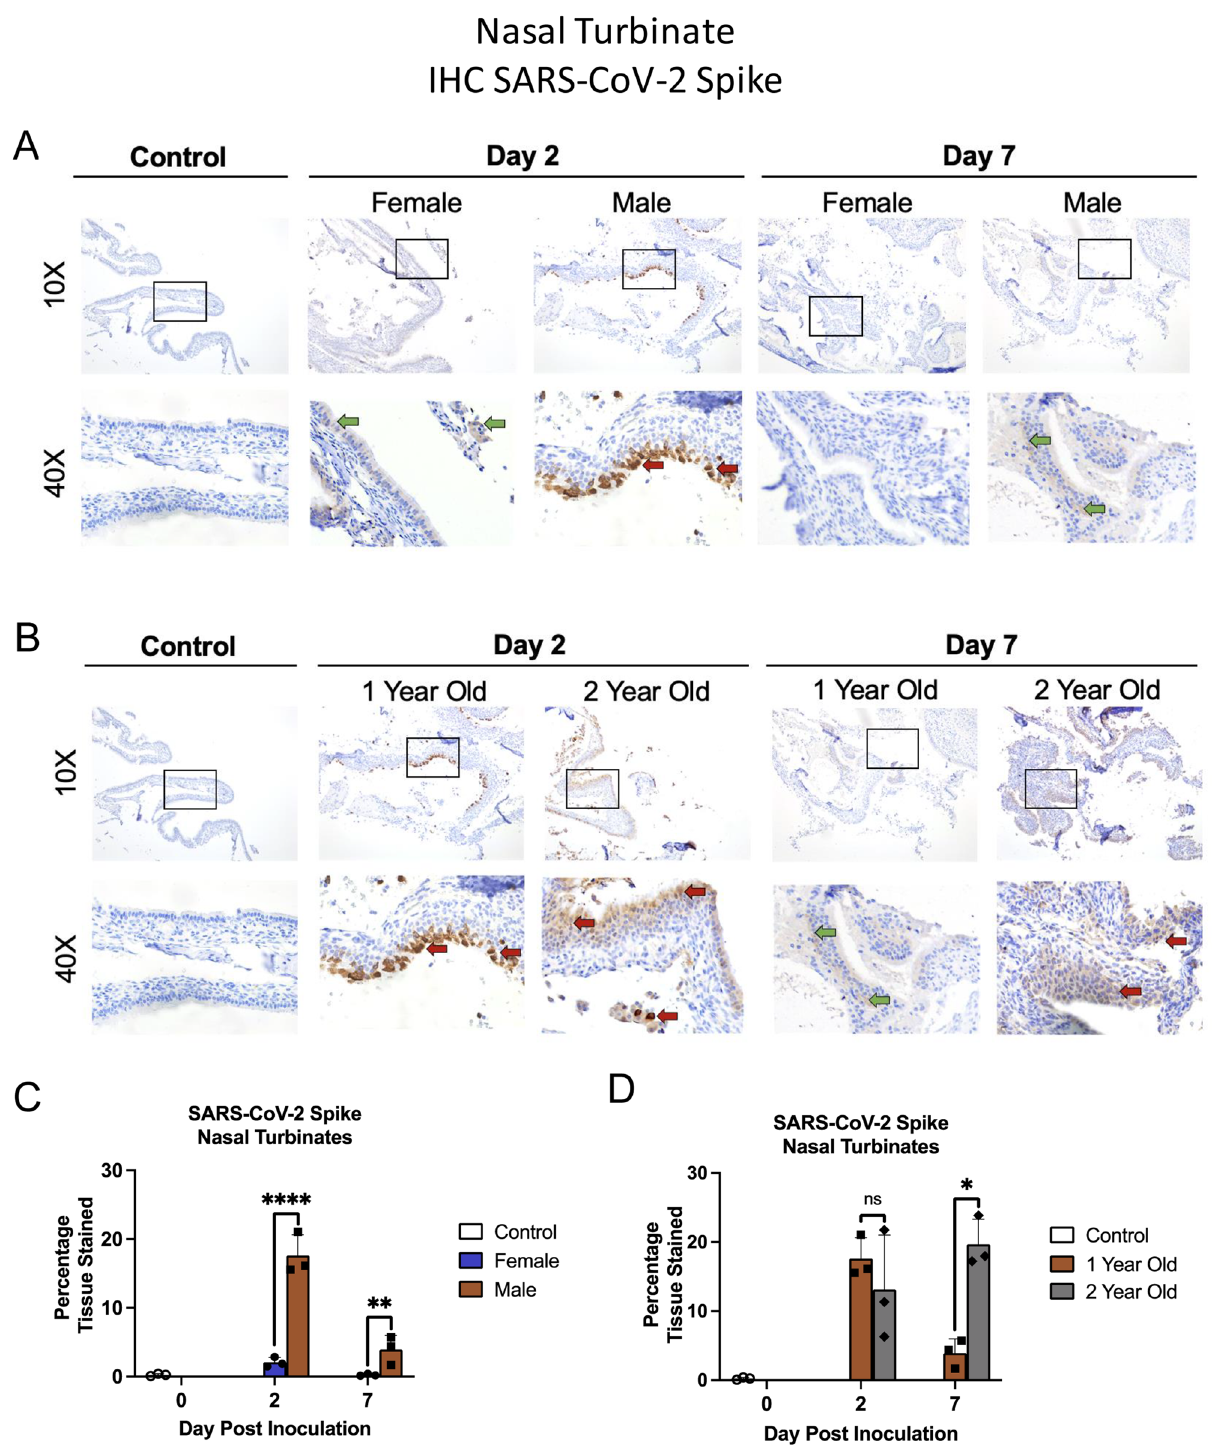
Figure 6. 2-year-old male ferrets have increased and prolonged SARS-CoV-2 viral antigen presence in nasal turbinates. ( A ) Formalin- fixed nasal turbinates collected from uninfected, control ferrets as well as female and male ferrets on days 2 and 7 post SARS-CoV-2 inoculation, were stained for SARS-CoV-2 spike protein. ( B ) Formalin-fixed nasal turbinates collected from uninfected, control ferrets as well as 1-year-old and 2-year-old ferrets on days 2 and 7 post SARS-CoV-2 inoculation, were stained for SARS-CoV-2 spike protein. Red arrows indicate high amounts of viral antigen staining and green arrows indicate low amount of viral antigen staining by immunohistochemistry (IHC) using an anti-spike rabbit monoclonal antibody. Stained tissues were visualized, and images captured using a Leica DMI100 Brightfield microscope and camera. Images were captured at 10× and 40×. Images shown are representative of three animals per group, per timepoint. ( C ) Staining was quantified utilizing Image-J in age matched female and male ferret nasal turbinates ( D ) and 1-year-old and 2-year-old ferret using scans of entire tissue captured by Aperio ScanScope XT slide scanner. Error bars represent SD. *A p-value of less than 0.05 as determined by ANOVA. Three animals were analyzed at each time point for all